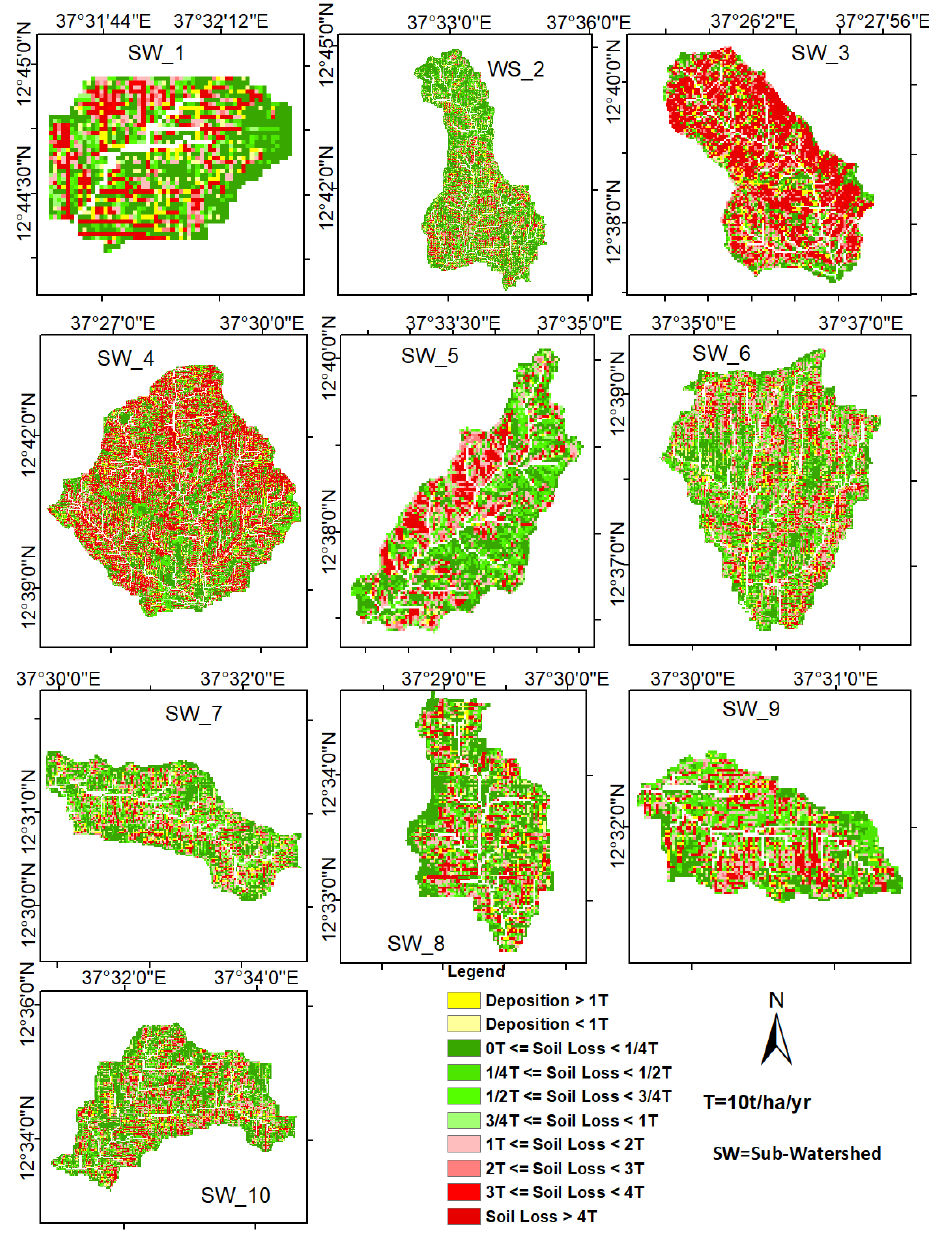
Figure 11. Onsite (flow path) method of the GeoWEPP model simulation annual soil loss and deposition rates relative to the tolerable (T = 10 t/ha/year.) soil loss rates for 10 sub-watersheds.